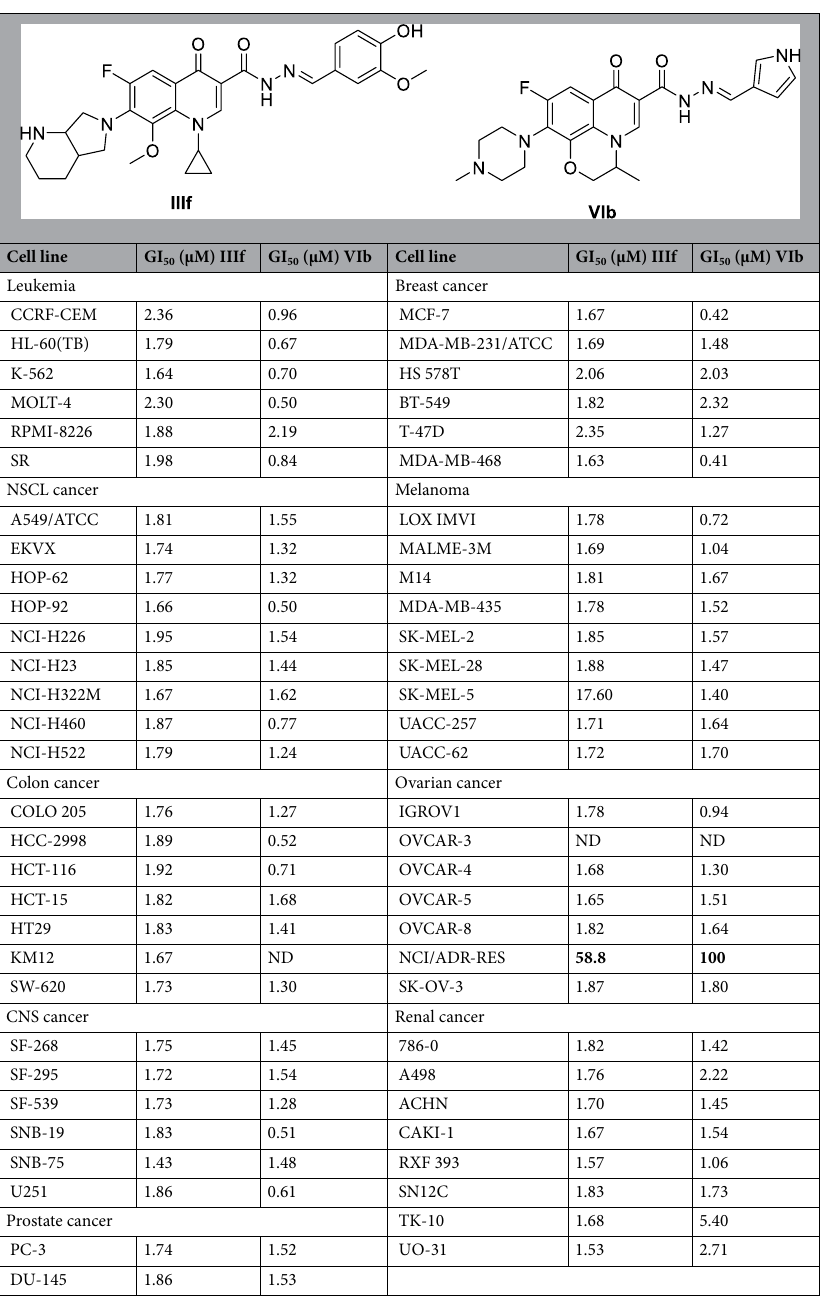
Table 2. Concentrations for 50% growth inhibition (GI 50 ) of compounds ( IIIf ) and ( VIb ) expressed in µM as determined in the NCI-60 Human Tumor Cell Lines Screen five-dose assay. ND not determined. Structures Generated using ChemDraw 2021 (https:// perki nelme rinfo rmati cs. com/ produ cts/ resea rch/ chemd raw) 19 .